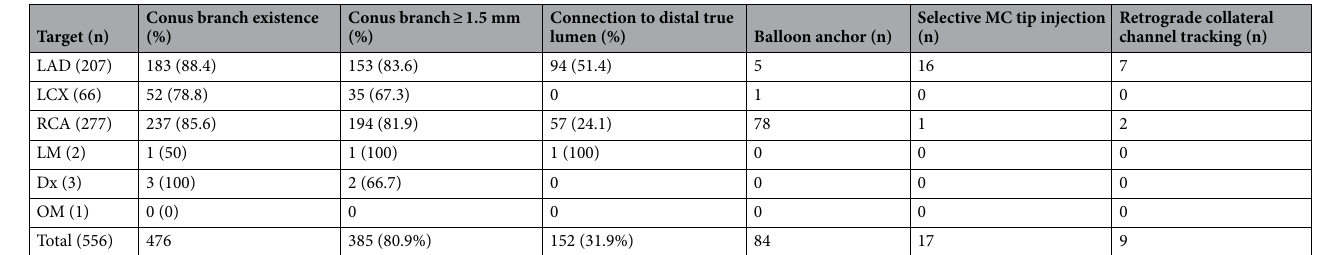
Table 3. Conus Branch Existence and Utilization During CTO PCI (per CTO). LAD left anterior descending artery, LCX left circumflex artery, RCA right coronary artery, LM left main coronary artery, Dx diagonal branch, OM obtuse marginal branch, MC microcatheter.